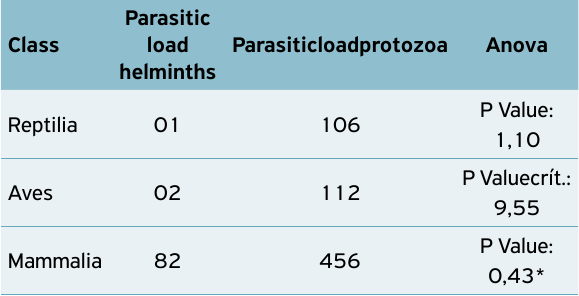
Table 2. Parasitic load (number of eggs or cysts / slide) by class of animals and analysis of ANOVA two factors between the